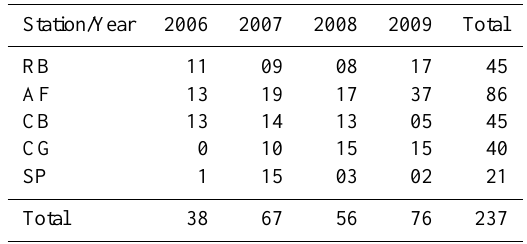
Table 4. AERONET correlative measurement days for CALIOP closest approach distances less than 100km.